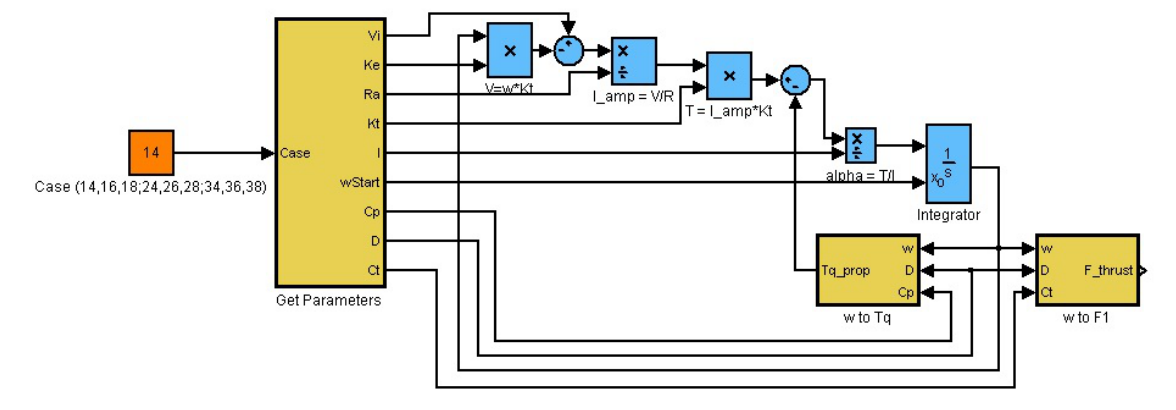
Figure 2: Simulink implementation of multirotor actuator